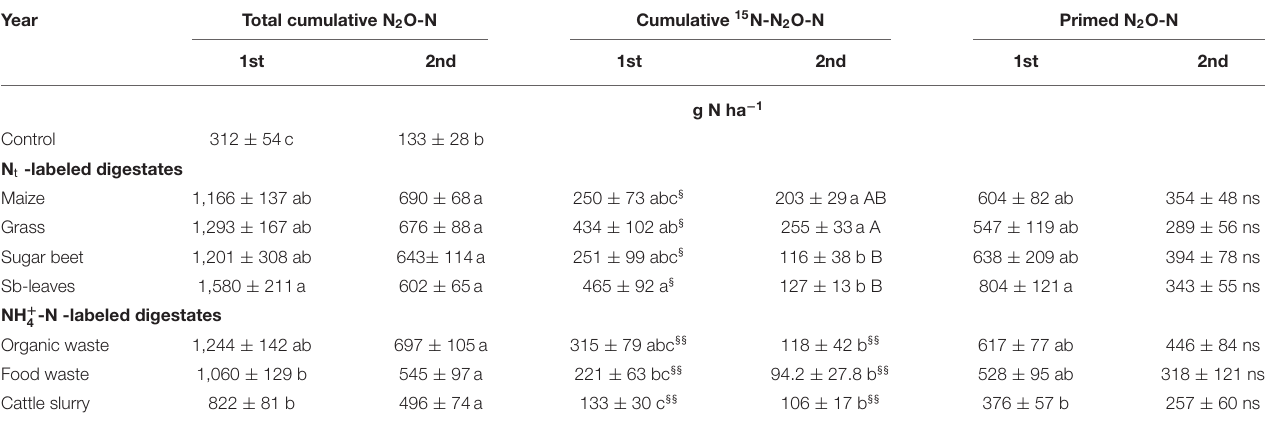
TABLE 4 | Total cumulative N 2 O-N, 15 N-N 2 O-N emissions, and primed N 2 O-N emissions after 55 (1st) and 58 days (2nd